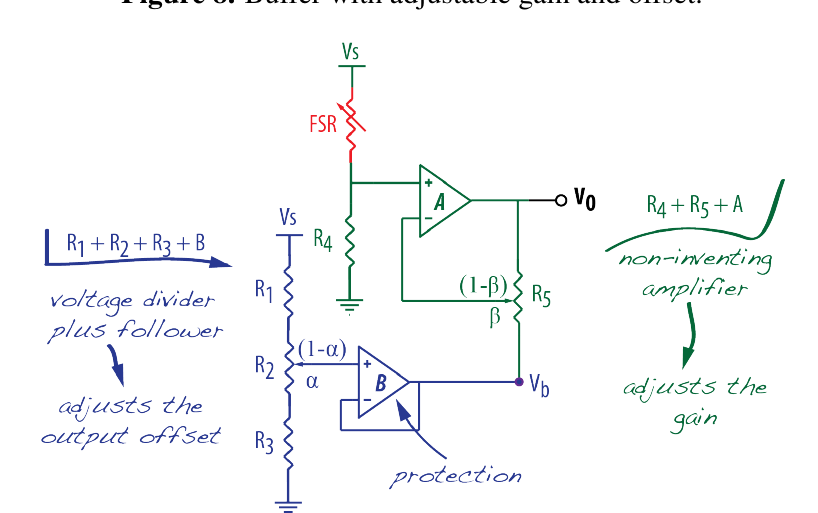
Figure 8. Buffer with adjustable gain and offset.